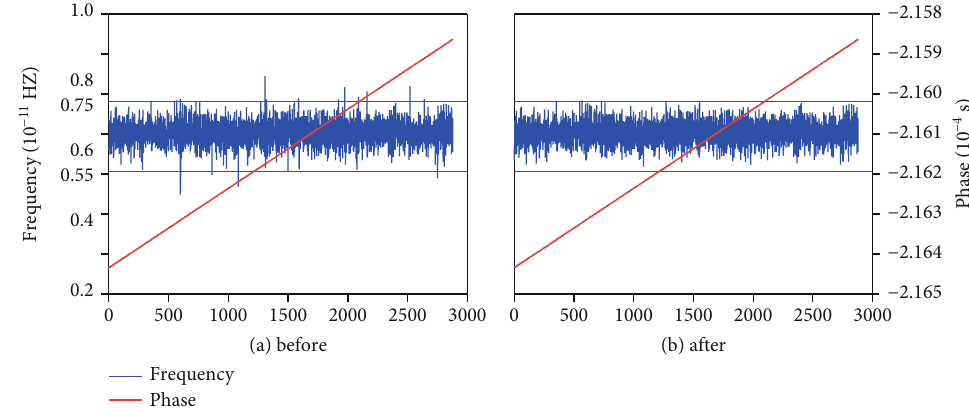
Figure 3: The gross error detection results of C28 SCB data: (a) the original data; (b) the data preprocessed by